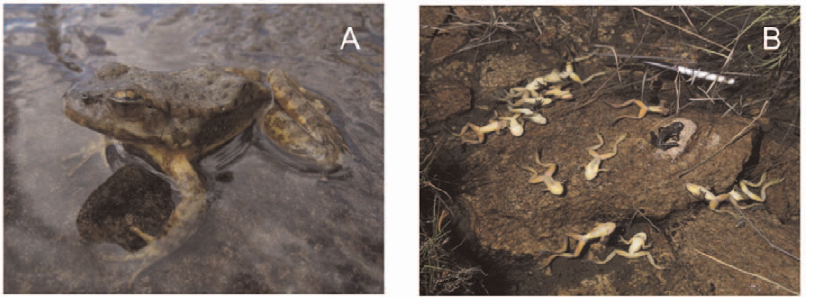
Figure 2. Appearance and behavior of mountain yellow-legged frogs ( Ranamuscosa ) and during a chytridiomycosis outbreak in Sixty Lakes Basin, Sierra Nevada Mountains, California. A) A frog showing clinical signs of severe chytridiomycosis including abnormal posture. B) Dead frogs following a chytridiomycosis outbreak in Milestone Basin.